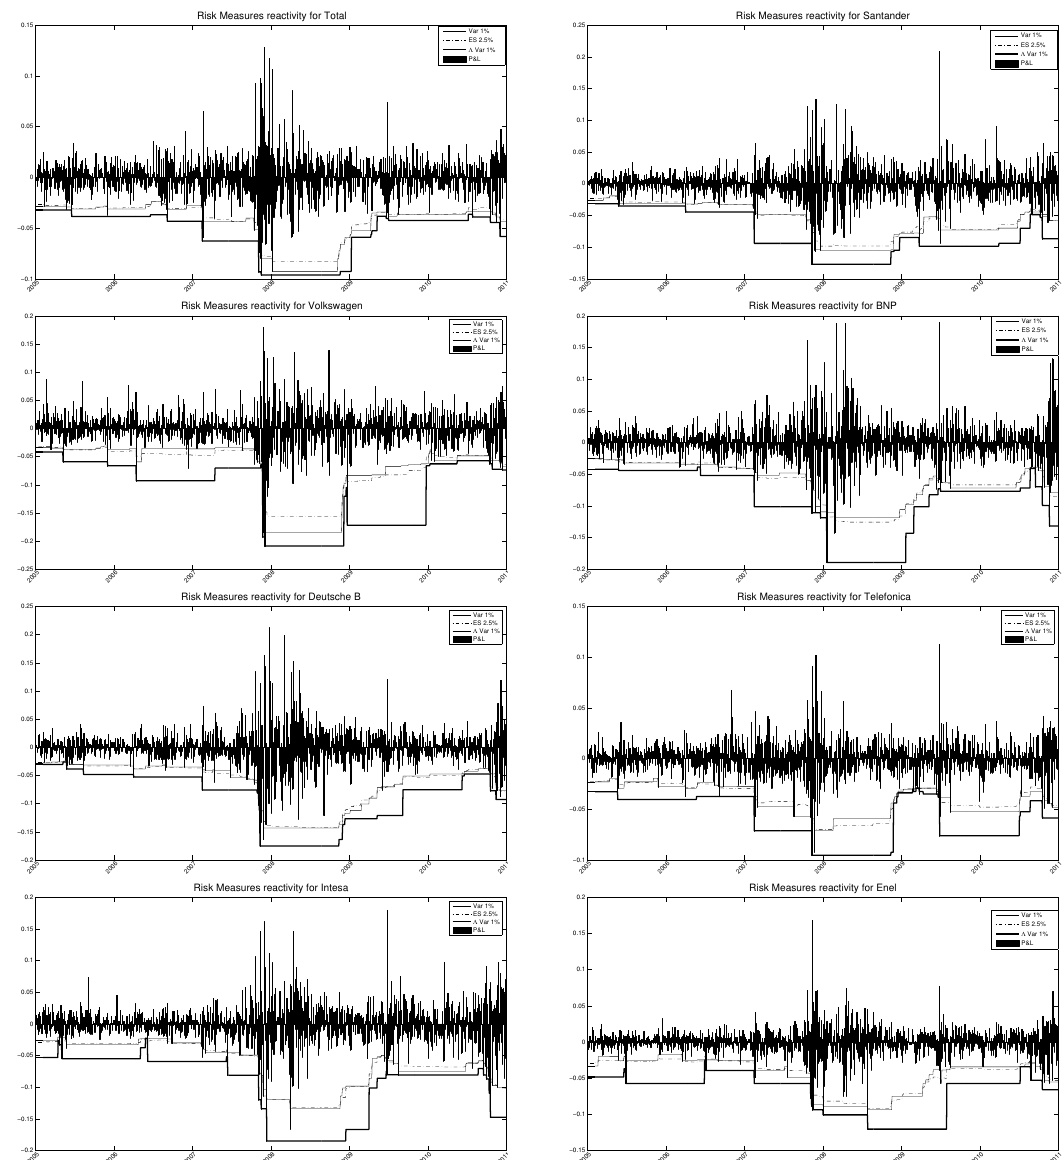
Figure 2. Different reactivity to market fluctuations of VaR , ES and Λ VaR under historical simulation. The Λ VaR is the most conservative measure and has higher reactivity to adverse market conditions than the VaR and the ES . Its behaviour is in line with the other risk measures during stable